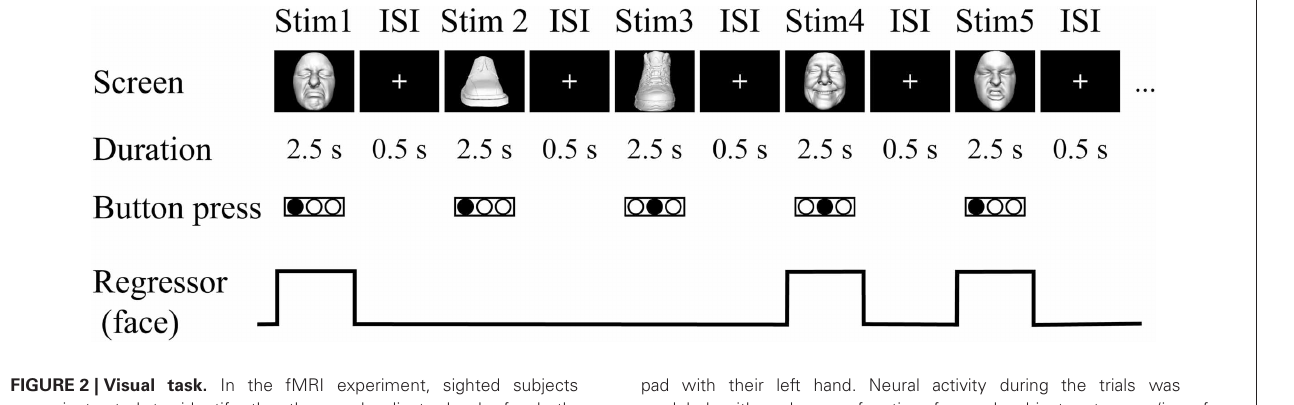
pad with their left hand. Neural activity during the trials was modeled with a box-car function for each object category (i.e., face and